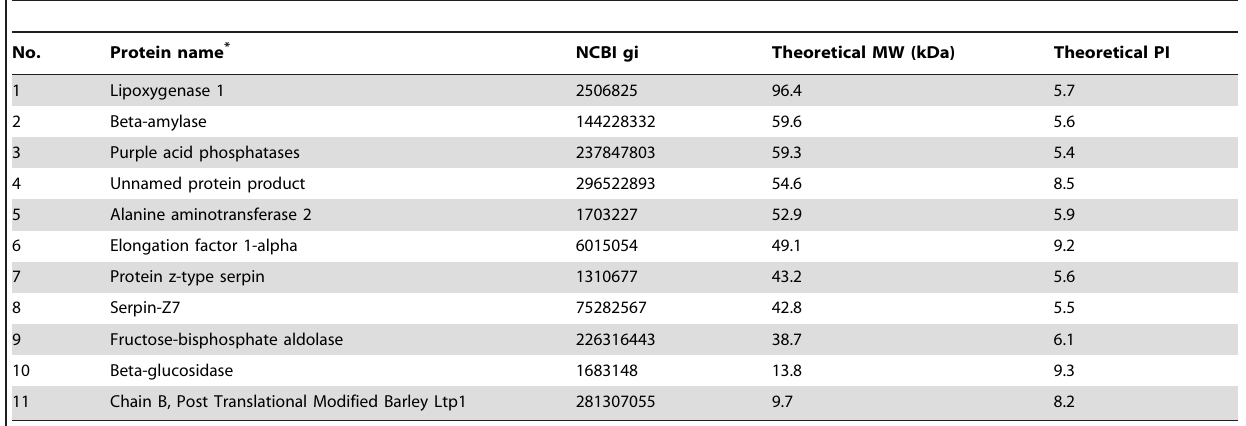
Table 2. Proteins identified by the LC-MS/MS analysis in purified phytase